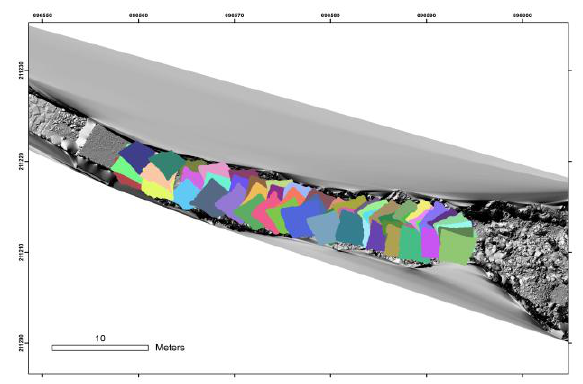
Figure 2 RIM footprints overlapping a laser scan from the study site